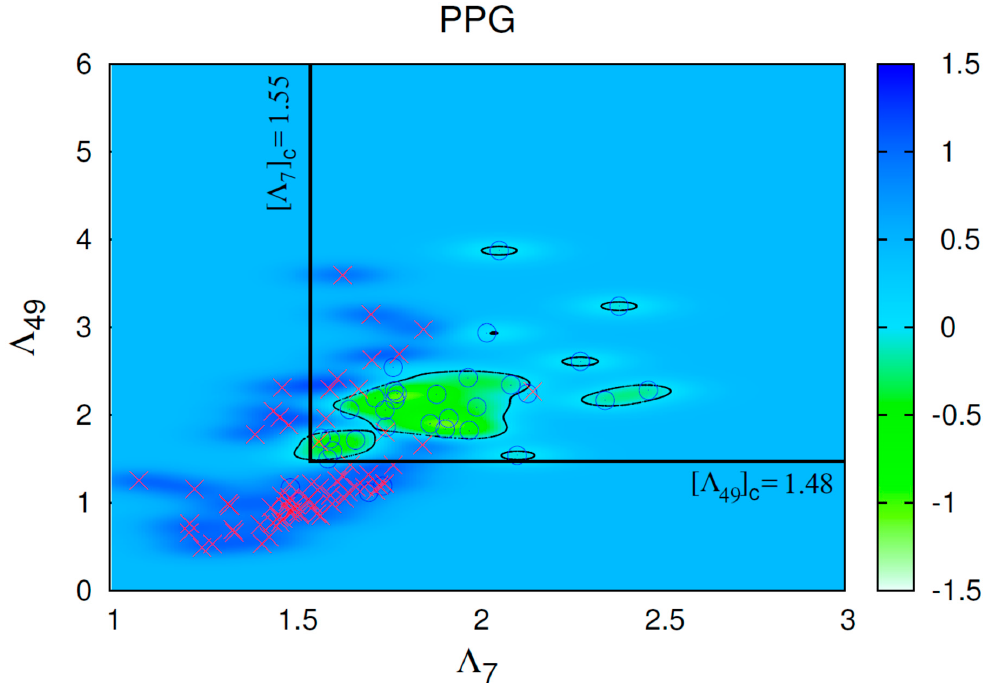
Figure 9. Results comprising 32 Healthy (blue circles) and 67 congestive heart failure (CHF) (red crosses) individuals. The color contours correspond to the argument of the signum in the decision function of Equation (12) obtained by Support Vector Machines (SVM) with radial basis kernel function with γ = 50. The black dotted points correspond to the decision boundary and enclose the healthy (H) region found by SVM.